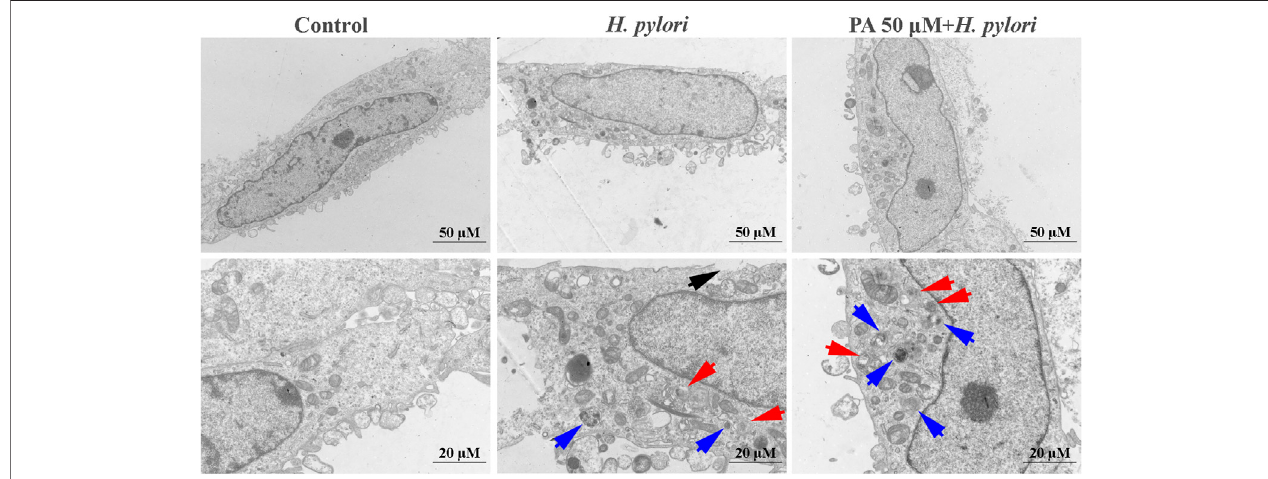
FIGURE 4 | Representative TEM micrographs of the ultrastructures of H. pylori -infected GES-1 cells. Double-membraned autophagosomes, red arrows; single- membraned autolysosomes, blue arrows; damaged cell membranes, black arrows.